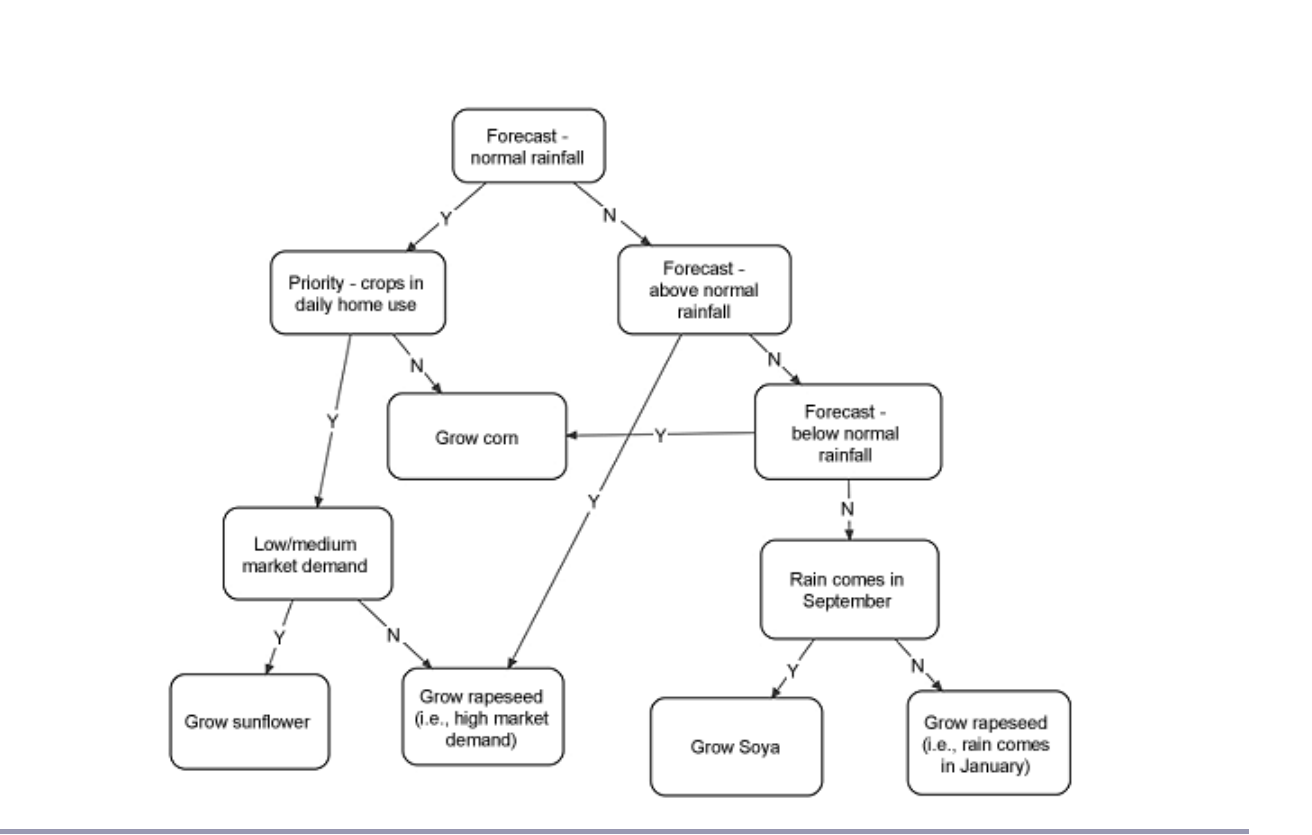
Fig. 3 . Portion of a decision